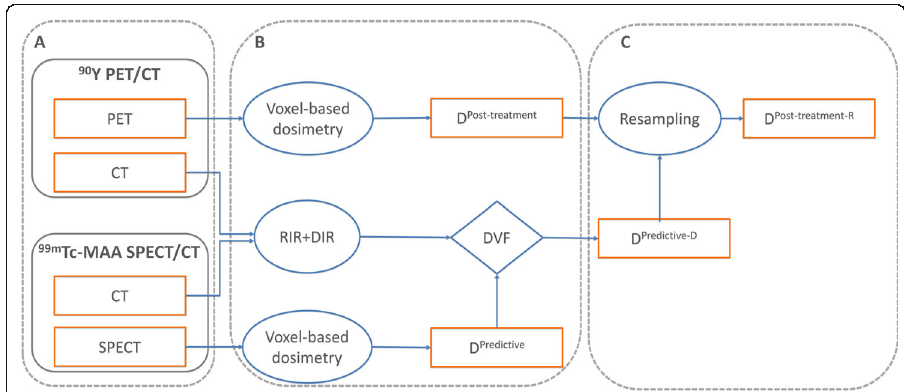
Fig. 1 Schematic representation of the post-processing workflow. a 90 Y-PET/CT and 99m Tc-MAA SPECT/CT images. b Dose matrices computed using the Planet Onco clinical workstation. Deformable image registration (DIR) and generation of the deformable vector field (DVF) using the validated HybridReg software. The deformation vector field (DVF) combines image information (i.e. intensities) with anatomical information provided by contoured image sets. The CT from the 99m Tc-MAA-SPECT/CT was non-rigidly registered to the CT from the 90 Y-PET/CT and using the liver VOIs as deformation constrain. Image intensity- based deformations were therefore restricted to remain within the corresponding liver VOI representations, while outside intensities were discarded. To minimize deformation-induced modifications of D Predicitve voxel values, the deformation knot grid and the MAA image resolution [cm/voxel] were kept around the same order (~ 0.5 cm/voxel). c Application of the DVF to the D Predicitve (called D Predicitve-D ). The D Post-treatment was resampled (D Post-treatment-R ) to the grid of D Predicitve-D to accomplish voxel-to-voxel alignment (= identical grid position and spacing), using a trilinear interpolation